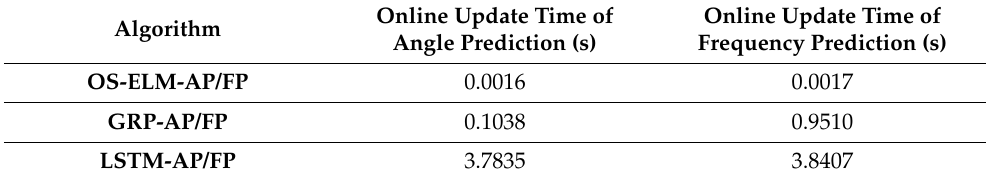
Figure 8. Online single-time interference frequency prediction results. ( a ) Prediction error for the Markov case. ( b ) Magnified view of ( a ). ( c ) Prediction error for the triangular sweep case. ( d ) Magnified view of ( c ). ( e ) Prediction error for the stochastic case. ( f ) Magnified view of ( e ). ( g ) Prediction error for the barrage case. Table 5. Numerical examples of the cost